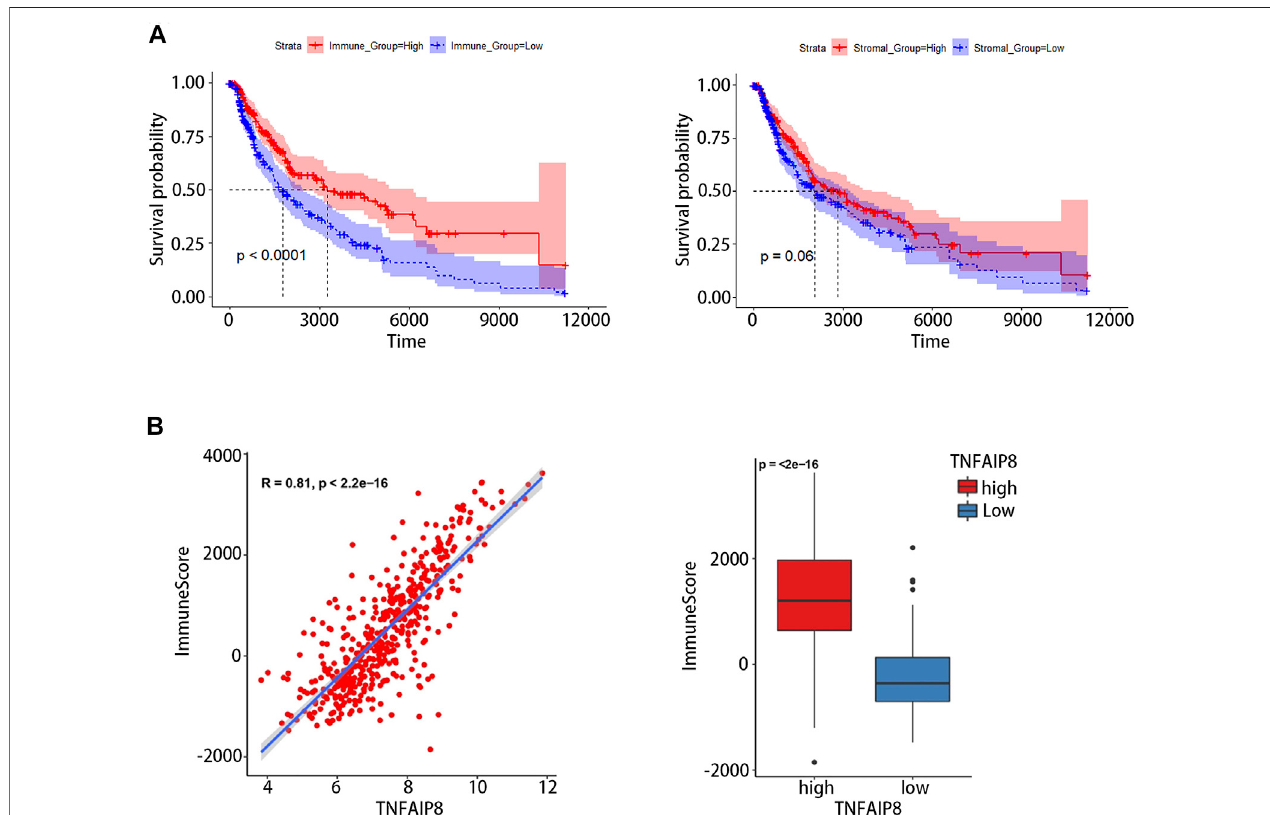
FIGURE7| Correlationbetweenthetumorimmuneenvironment(TME)andTNFAIP8expression. (A) CorrelationanalysisbetweenOSandtheimmunescore (left) or stromal score (right) . (B) Correlation between TNFAIP8 and the immune score by a linear graph (left) or dichotomy graph (right)